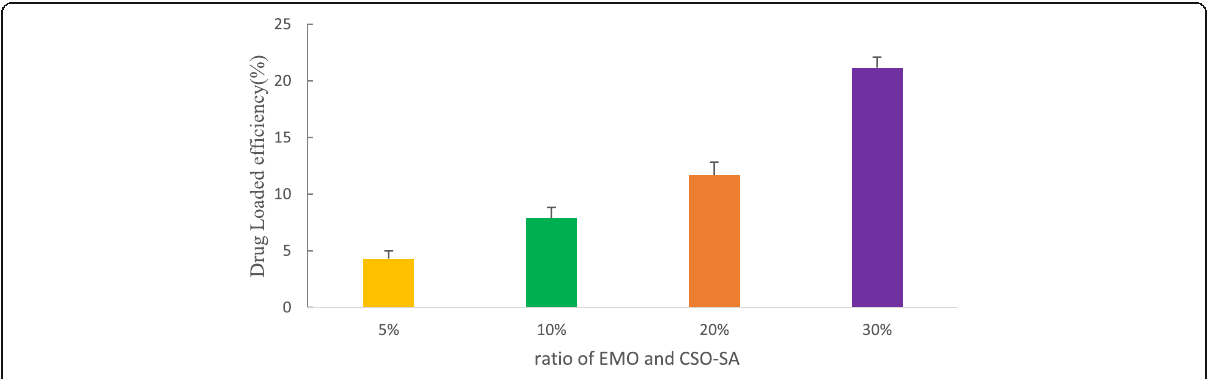
Fig. 5 The influence of different ratios of EMO and CSO-SA (5-30%) on drug loadings. Data are presented as the means ± SD ( n = 3)